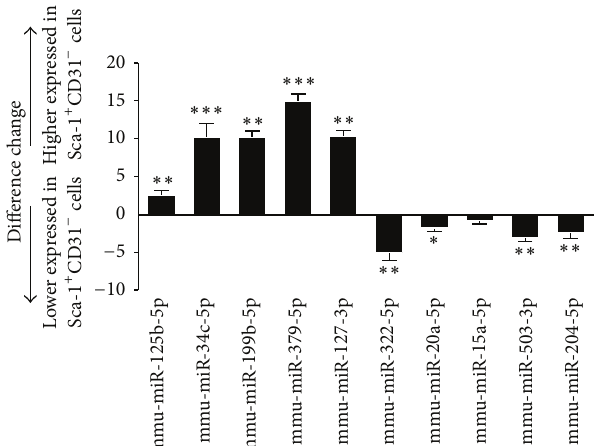
Figure 4: Expression profiles of miRNAs detected by dd-PCR. Bars: changes in miRNAs expression in Sca-1 + CD31 − cells versus Sca-1 + CD31 + cells. Expression was normalized to miRNA U6 and expression change was calculated based on the mean of three biological replicates. Bars above and below the 𝑥 -axis: upregulated and downregulated miRNAs in Sca-1 + CD31 − cells. Differences were analyzed with Student’s 𝑡 -test. ∗ 𝑃 < 0.05 , ∗∗ 𝑃 < 0.01 , and ∗∗∗ 𝑃 < 0.001 .